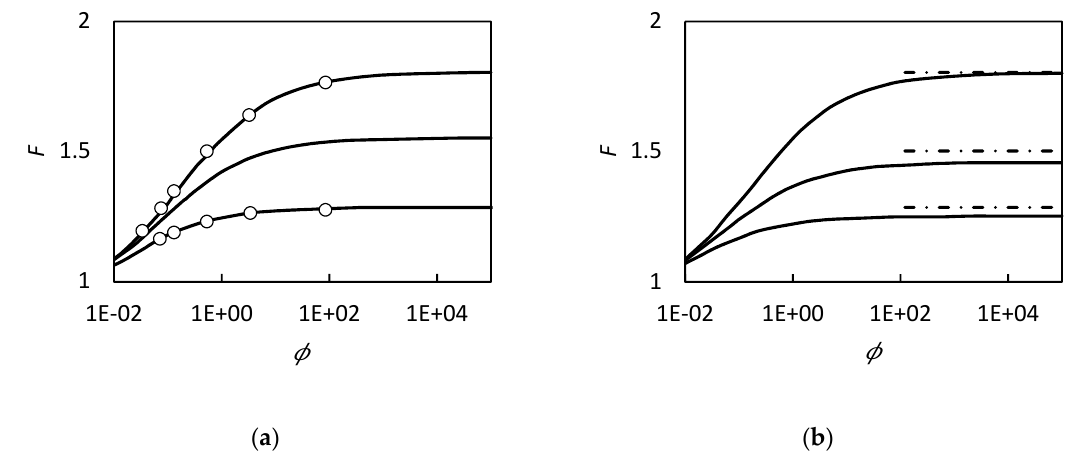
Figure 8. Facilitation factor as function of Damköhler number (Equation (157)). ( a ) Influence of the downstream solute concentration (dimensionless) for the case D AC = D C . From the top, C 1 Circles are numerical solution from Kutchai et al. [53], lines are calculations from the present model; ( b ) diffusivities ratio effect, r = D AC / D C , for zero downstream concentration. From the top, r = 1, r = 0.5, and r = 0.25. Continuous lines are the model of Morales and Cabrera [98], dash and dotted lines are the asymptotic solution of Teramoto [74].